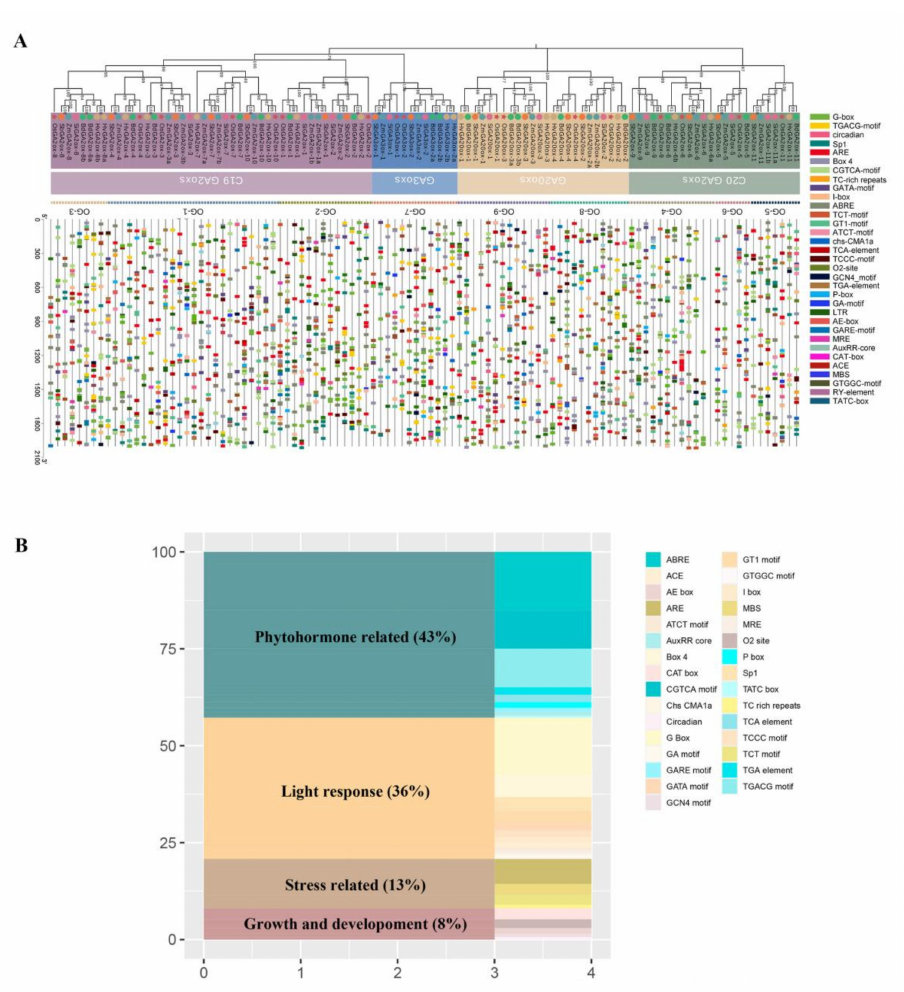
Figure 4. Analysis of cis-acting elements in GAox genes’ promoter regions. The legend describes the color of the cis-element. ( A ) Phylogenetic tree and the distribution of GAox genes’ cis-elements in six Gramineae. ( B ) The ratios of cis-elements classified by